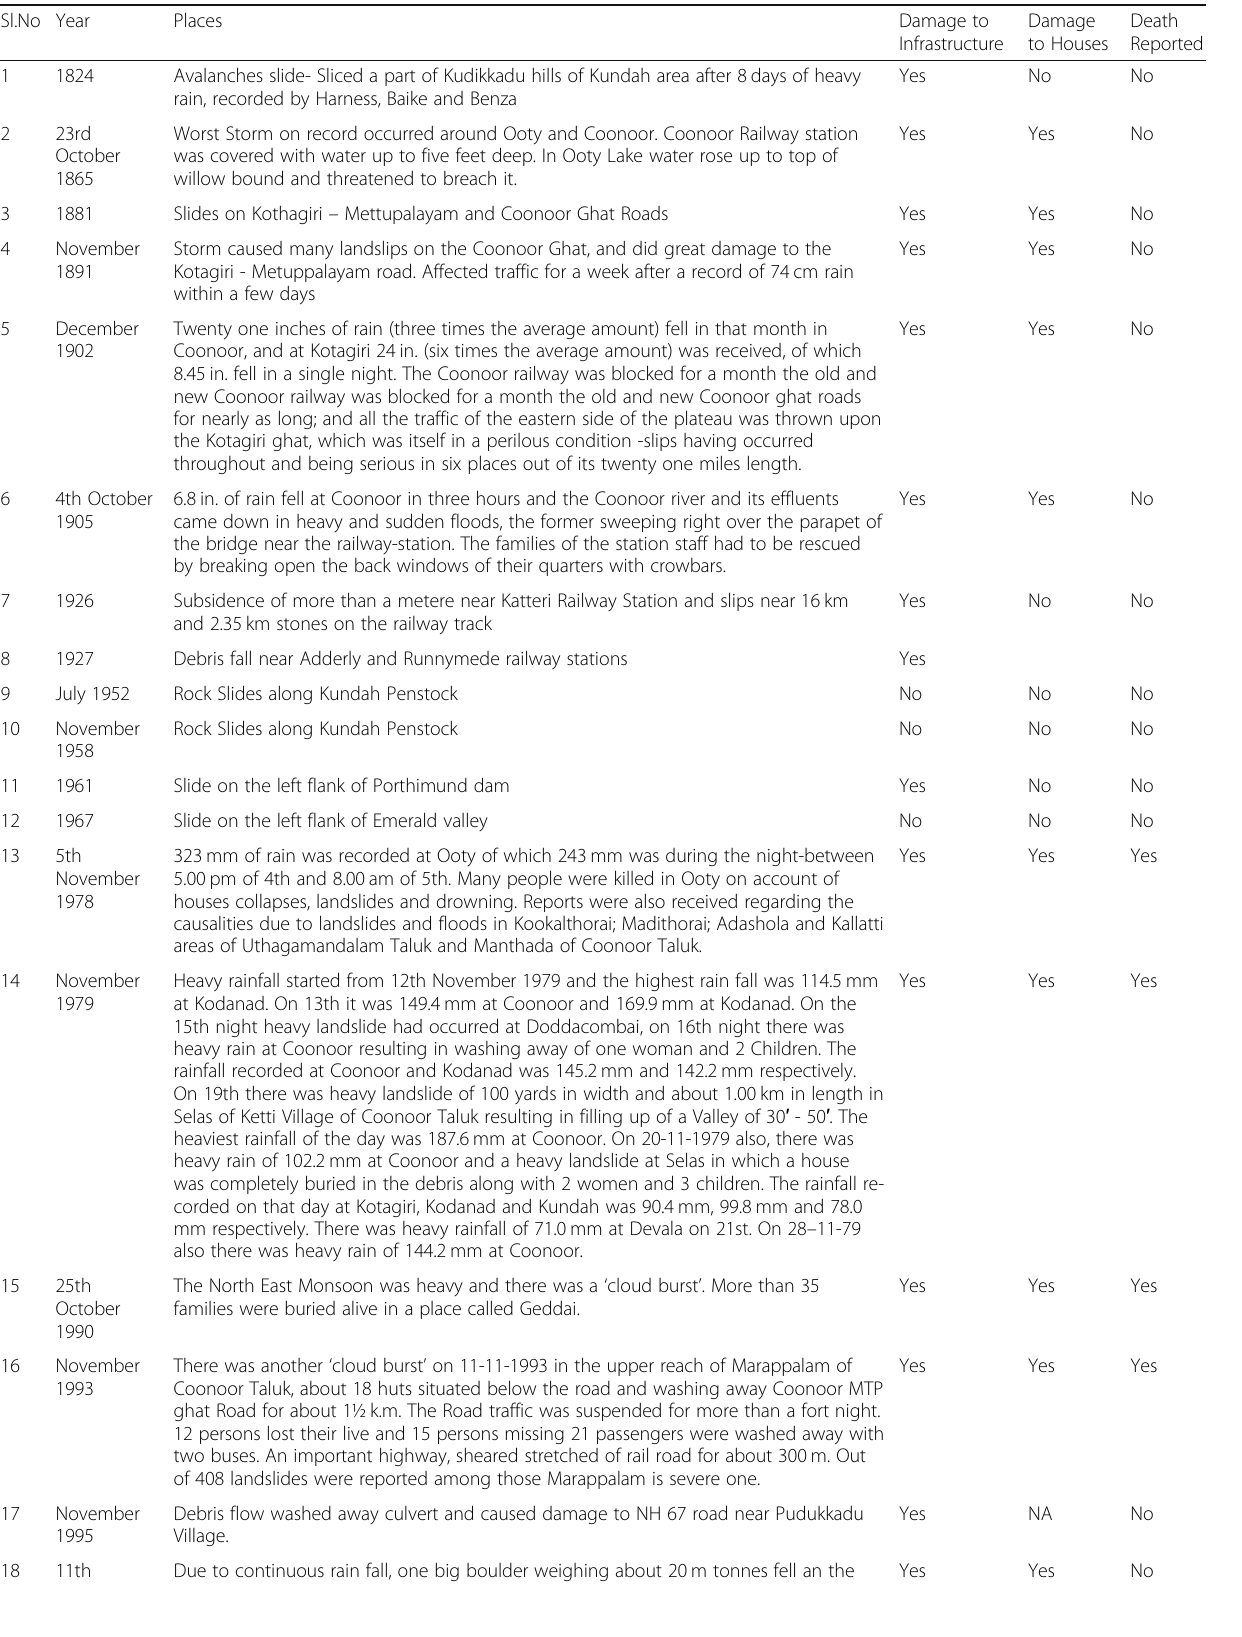
Table 1 Historical landslides and the damage consequence in the Nilgiris District Sl.No